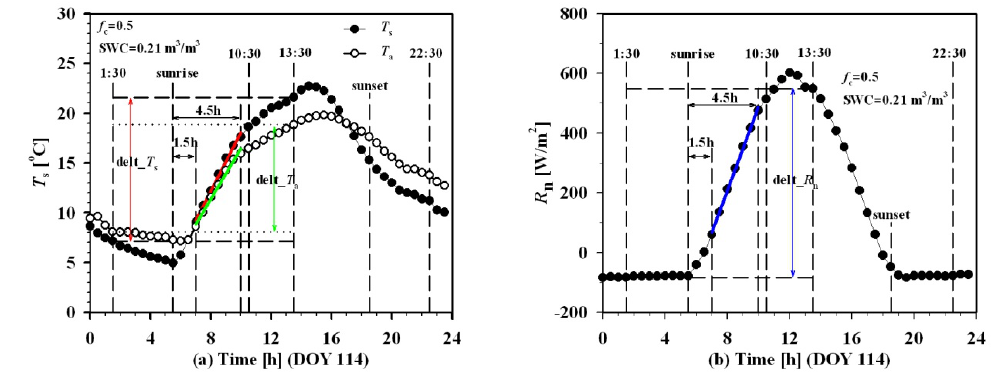
Figure 6. Variations of ( a ) T and T , and ( b ) R during a diurnal cycle for an ALEX-simulated s a n ) of 0.5 and soil water content (SWC) of case given fractional vegetation cover ( f c 0.21 m 3 /m 3 and the atmospheric forcing at the Yucheng station on 24 April (DOY 114) 2010. The bold red, green, and blue lines denote the approximately linear variations of T , and R during the morning about from 1.5 h–4.5 h after sunrise. delt_ T T a n are the differences of T , T , and R between 1:30 P.M. and 1:30 A.M., delt_ R n s a n respectively. The sunrise is 5:30 A.M., and the sunset is 6:30 P.M. on 24